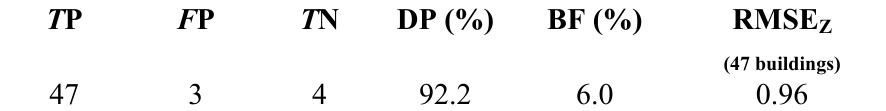
Table 1. Quantitative assessment of